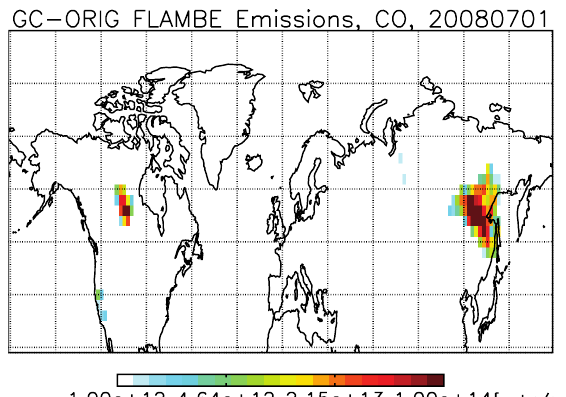
Fig. 2. Emissions of CO from extratropical fires on 1 July 2008 for the GC-ORIG model run. Estimates of the amount of biomass burned are from the FLAMBE database, while the emission factor for CO is from Andreae and Merlet